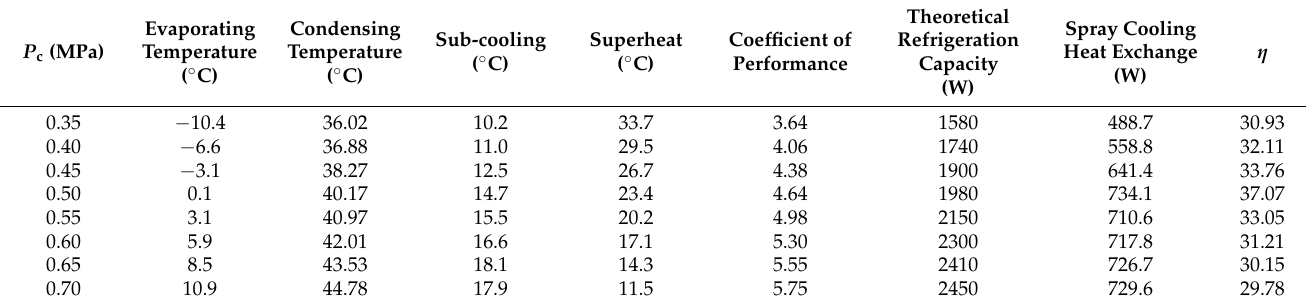
Table 4. Comparison of system parameters under different refrigerant